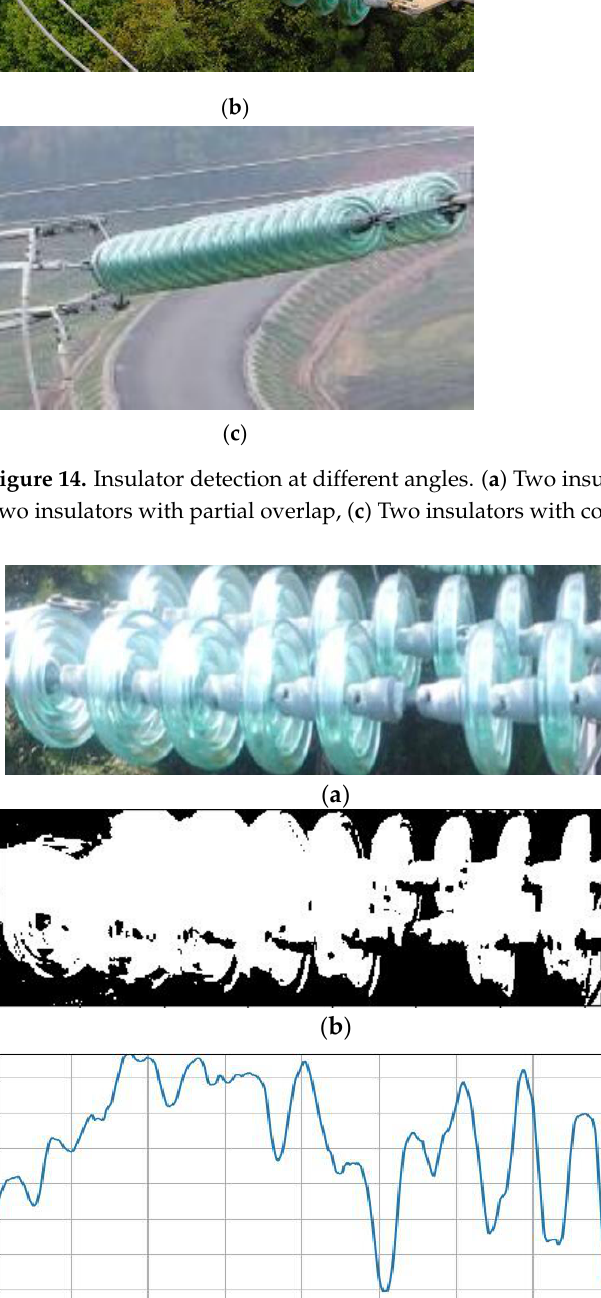
Figure 14. Insulator detection at different angles. ( a ) Two insulators without overlapping parts, ( b ) Two insulators with partial overlap, ( c ) Two insulators with complete overlap.